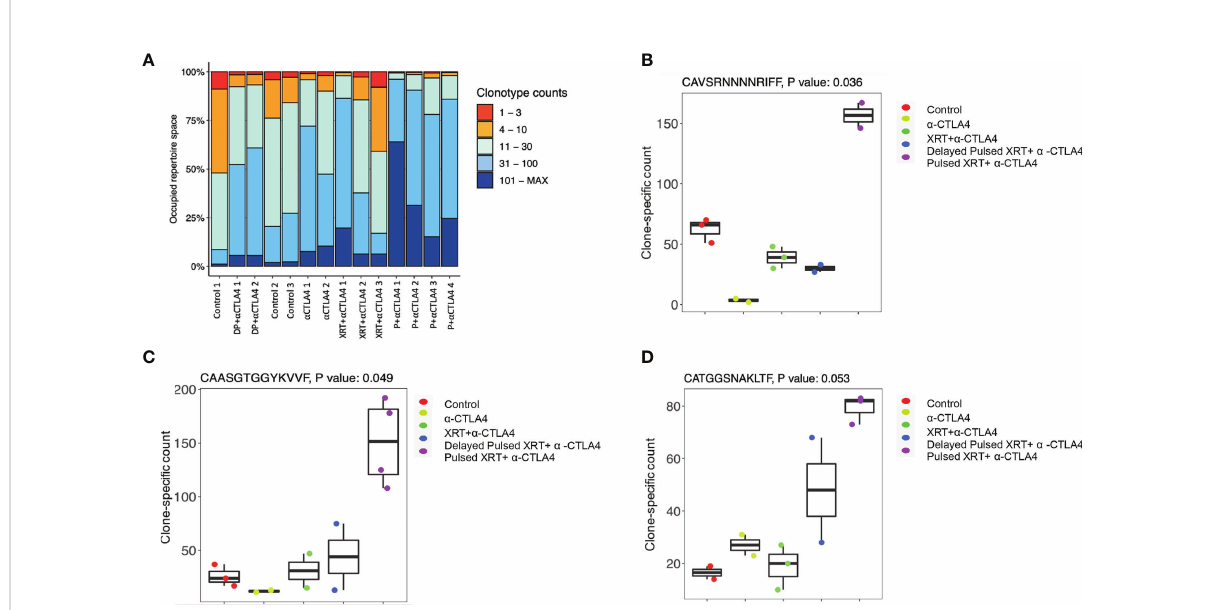
FIGURE 5 TCR repretoire analysis of different experimental groups. (A) Proportion of clonotypes with speci fi c counts. The proportion of clonotypes with speci fi c counts was higher in the pulsed XRT and anti-CTLA-4 group. DP, Delayed Pulsed XRT; P, Pulsed XRT. (B – D) Speci fi c clones (CAVSRNNNNRIFF, p = 0.036; CAASGTGGYKVVF, p = 0.049; CATGGSNAKLTF, p = 0.053) in the T-cell receptor repertoire that were signi fi cantly high in the Pulsed XRT + a -CTLA-4 group.